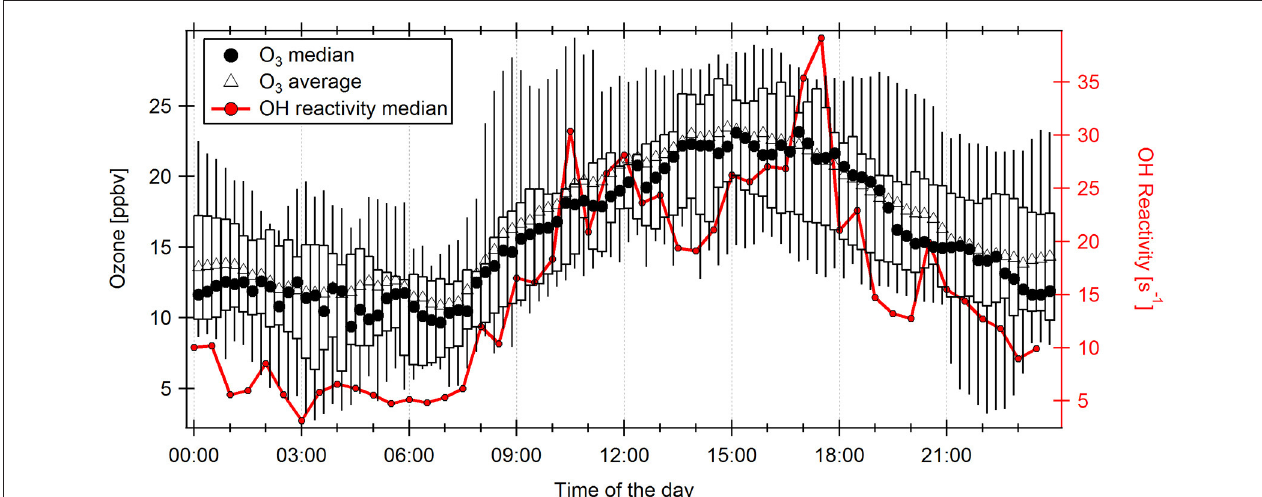
FIGURE 10 | Quarter-hourly diel cycle of Ozone measured at 38m height above ground level in November 2015 with medians (circles) and averages (triangles). Boxes and whiskers represent the 25–75th and 5–95th percentiles, respectively. The half-hourly median diel cycle of OH reactivity is displayed on the right